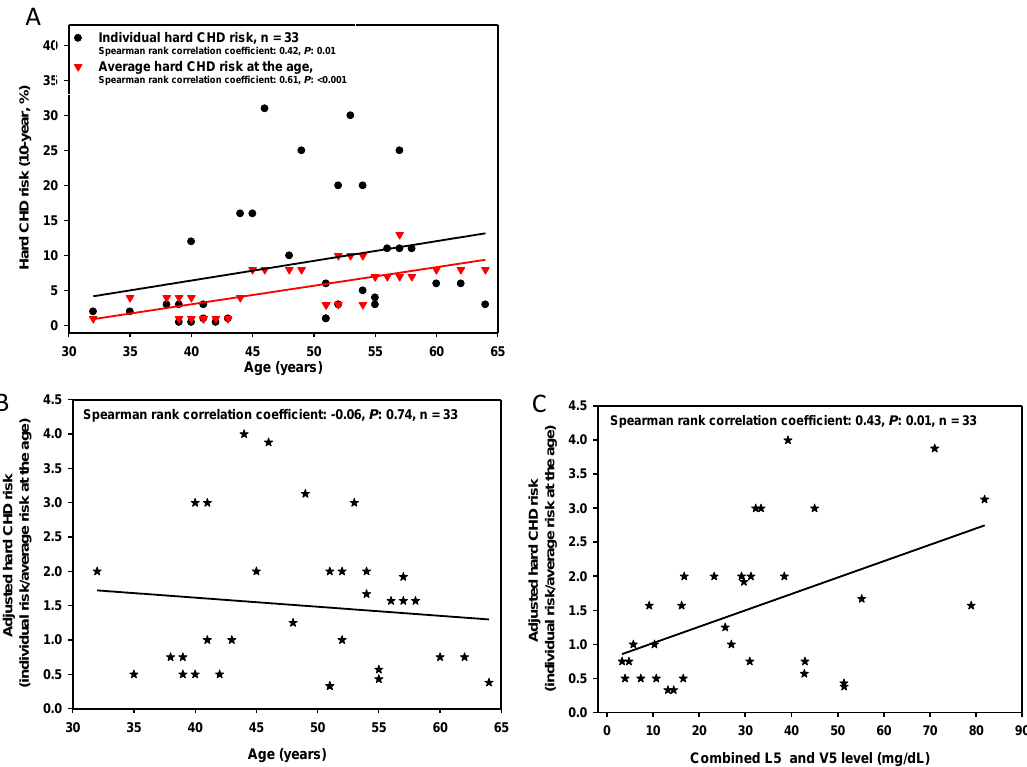
Figure 1. The relationship between combined L5 and V5 levels and coronary heart disease (CHD) risk according to the Framingham risk score. ( A ) Correlation between age and 10-year hard CHD (i.e., myocardial infarction, coronary death, or stroke) risk according to the Framingham risk score. ( B ) Correlation between age and adjusted hard CHD risk (i.e., hard CHD risk/average hard CHD risk at the age). The average hard CHD risk at the age is derived from the Framingham Heart Study [25] of a predominantly Caucasian population in Massachusetts, USA. ( C ) Correlation between the combined amount of L5 and V5 and adjusted hard CHD risk.